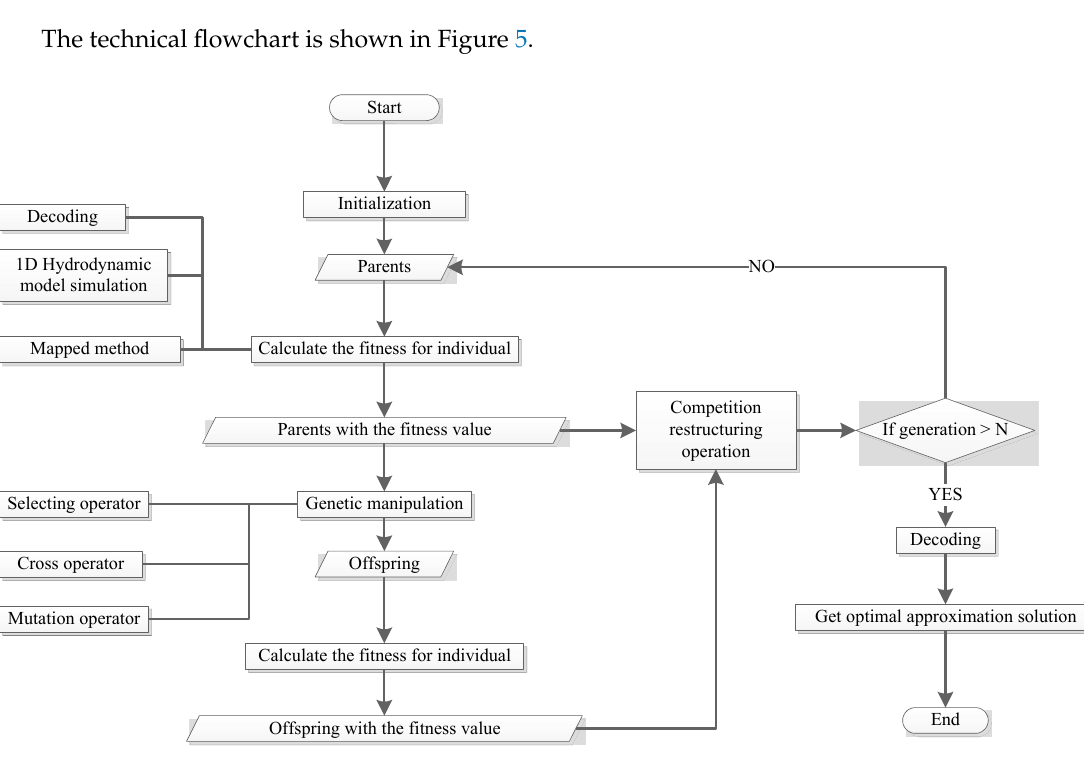
Figure 5. Flow chart of the genetic algorithm.